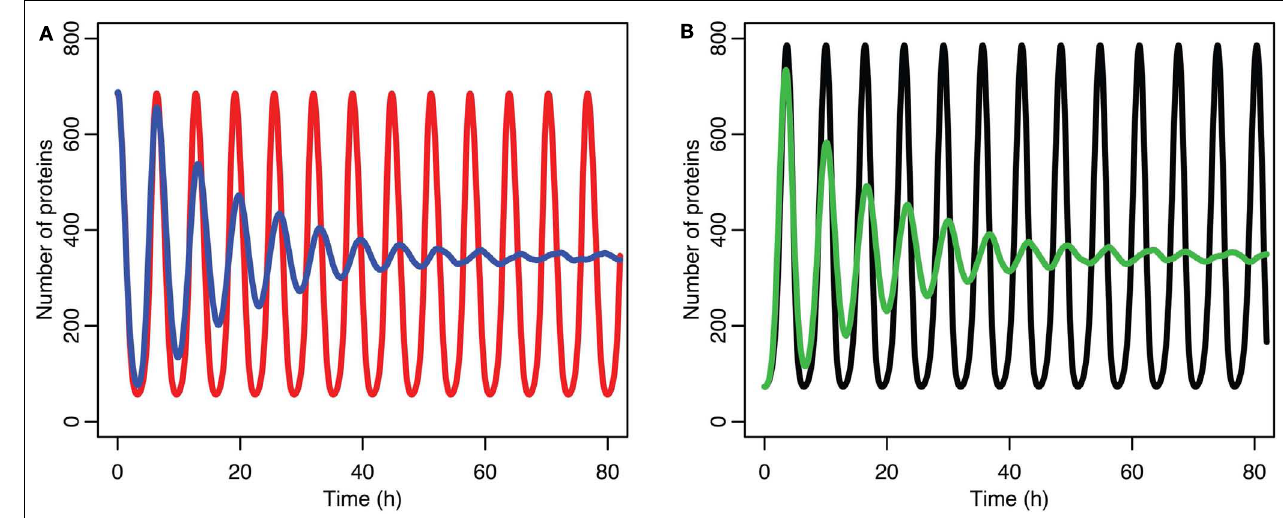
stochastic model in blue. (B) Shows the comparison for p53 with the deterministic model in black and from the mean of 5,000 runs of the stochastic model in green.